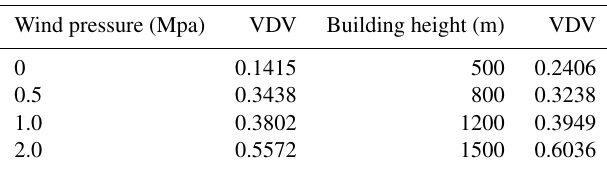
Table 2. The VDVs of elevator under situations with different wind pressure and building